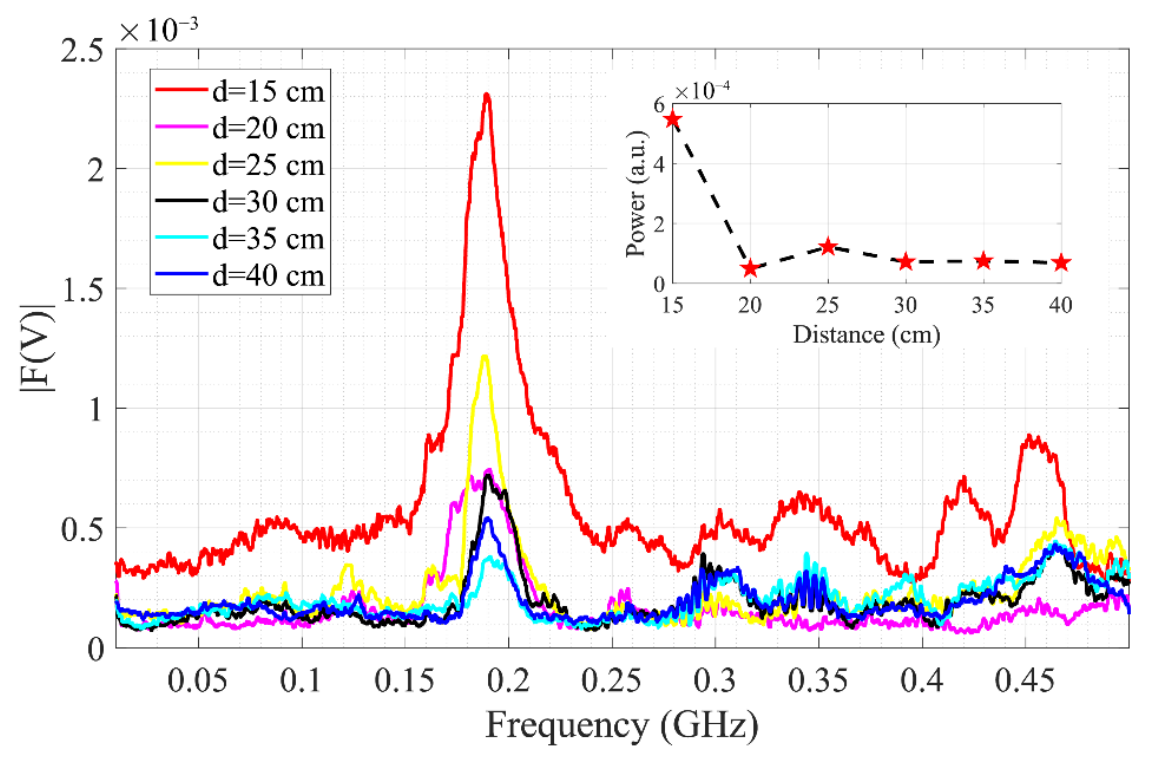
Figure 3. Typical frequency oscillogram of EMP at six values of the distance, where E = 170 mJ, t = 30 fs, d = 15~40 cm, θ = 0° (the inset shows the measured values of the EMP intensity at different detection distance).